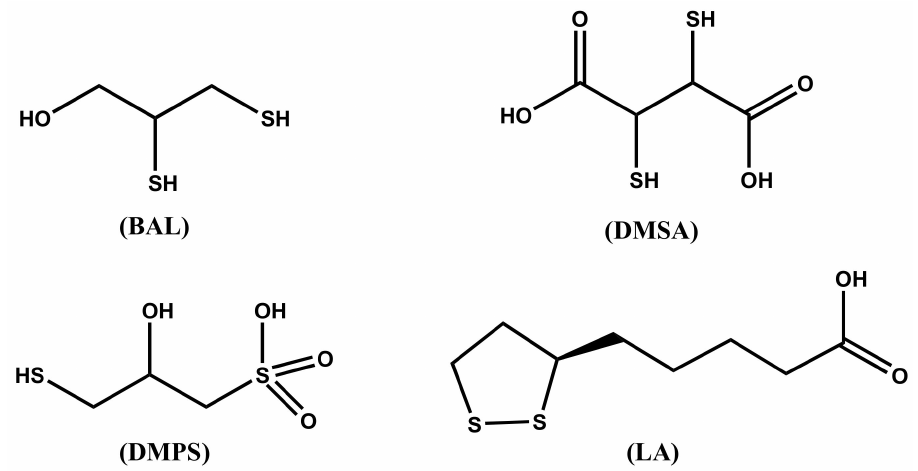
Figure 2. Molecular structure of the chelating agents used for mercury